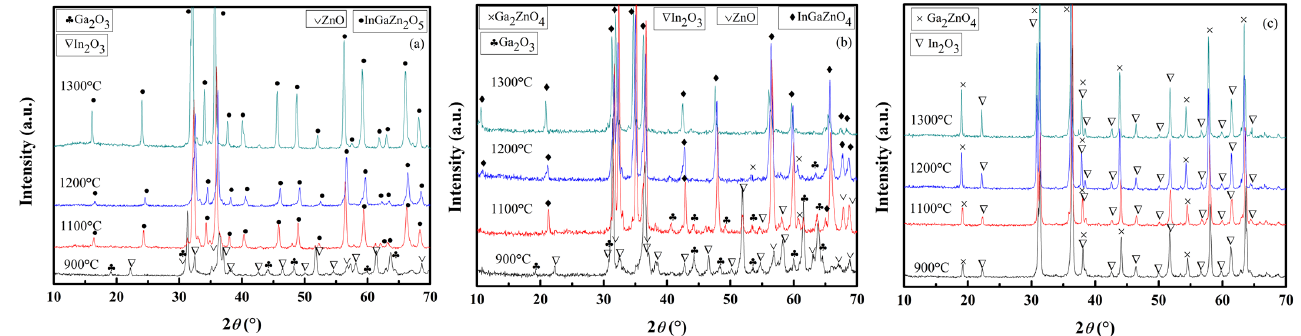
Figure 2. XRD patterns of ( a ) InGaZn 2 O 5 , ( b ) InGaZnO 4 , and ( c ) InGa 2 ZnO 5.5 sputtering targets sintered at temperatures from 900 °C to 1300 °C for 6 or 8 h.